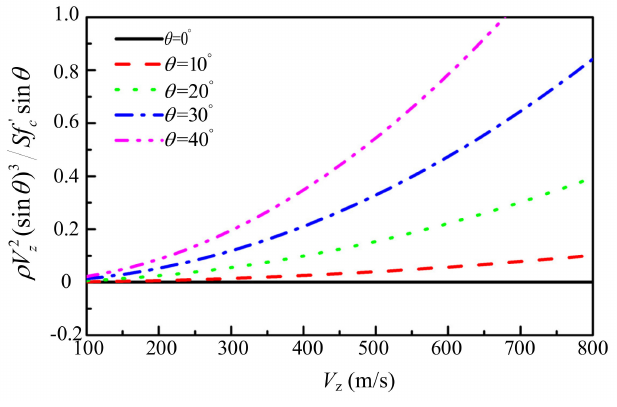
Figure 14. Curve of ρ V